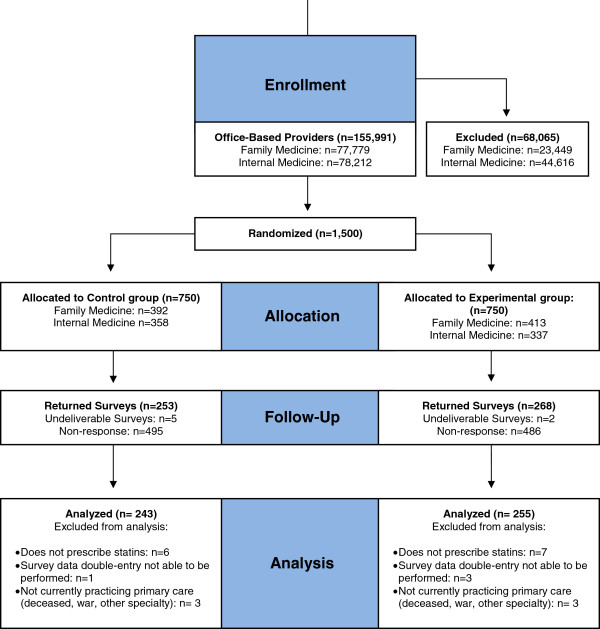
Flow of respondents through the randomized experiment.